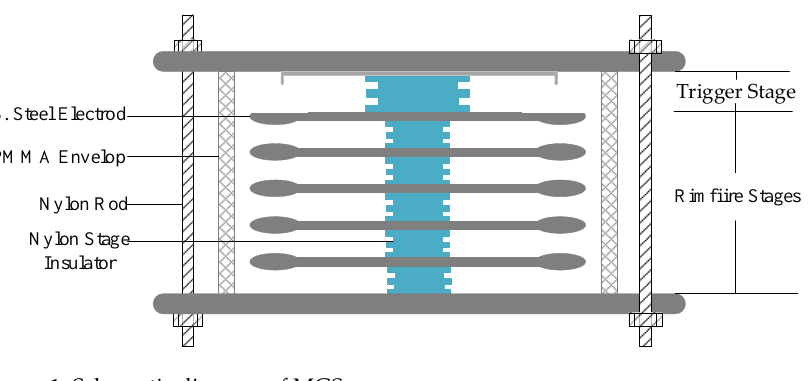
Figure 1. Schematic diagram of MGS.